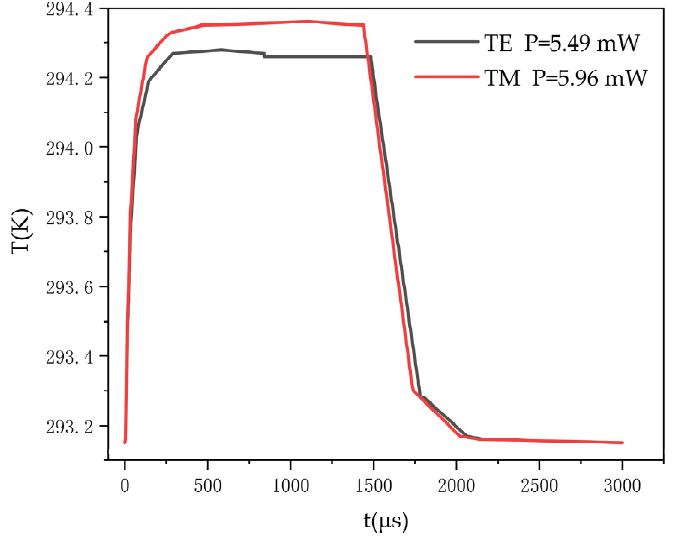
Figure 10. The response times for the polymer/silica switch with an air trench for TE mode and TM TM mode.